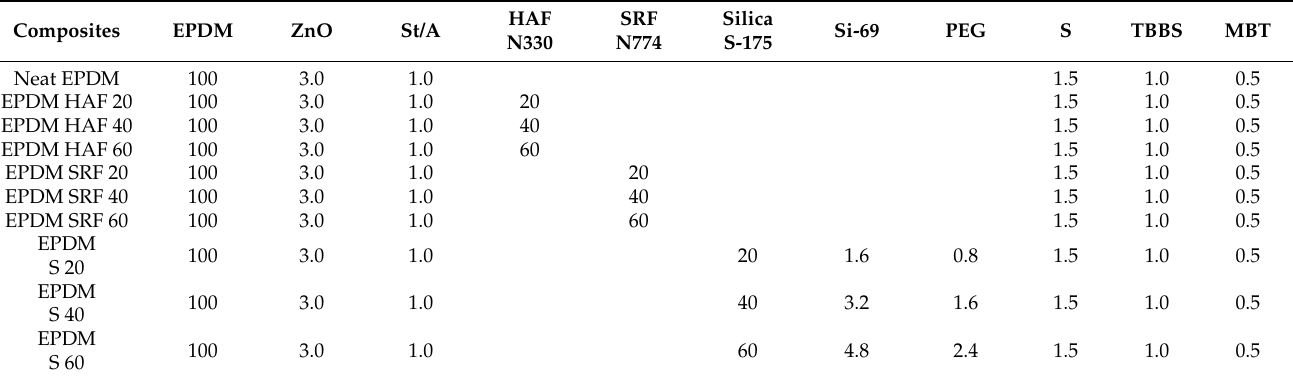
Table 1. Chemical compositions of sulfur-crosslinked EPDM rubber composites filled with HAF CB, SRF CB, and S